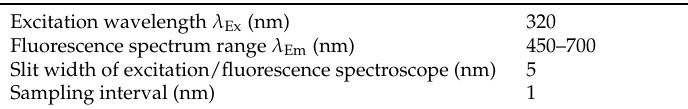
Table 1. Spectrofluorophotometer